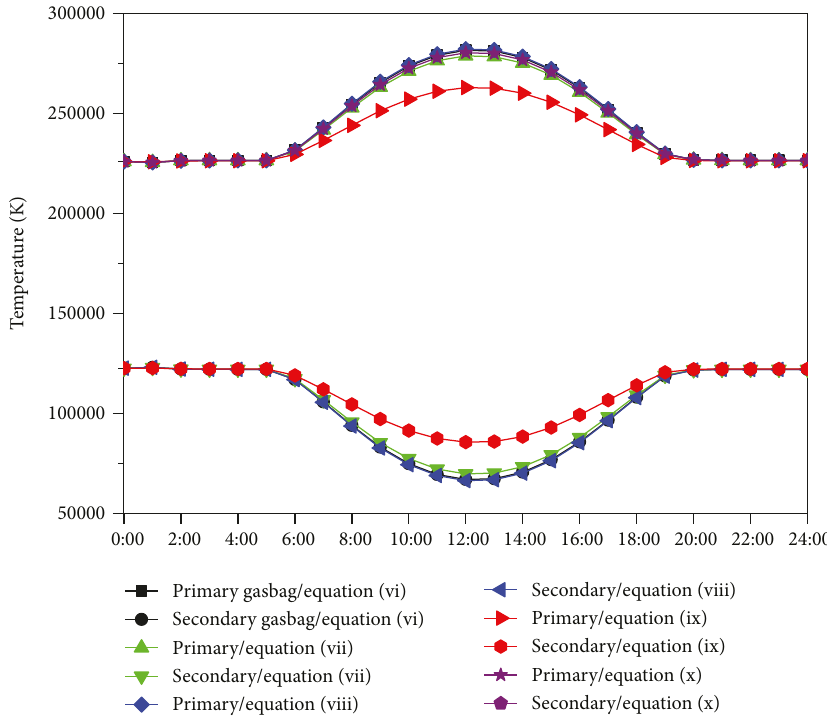
Figure 8: Helium gasbag volume changes calculated by di ff erent forced convection equations. Table 3: Heat fl ux of the upper envelope calculated by di ff erent forced convection equations.